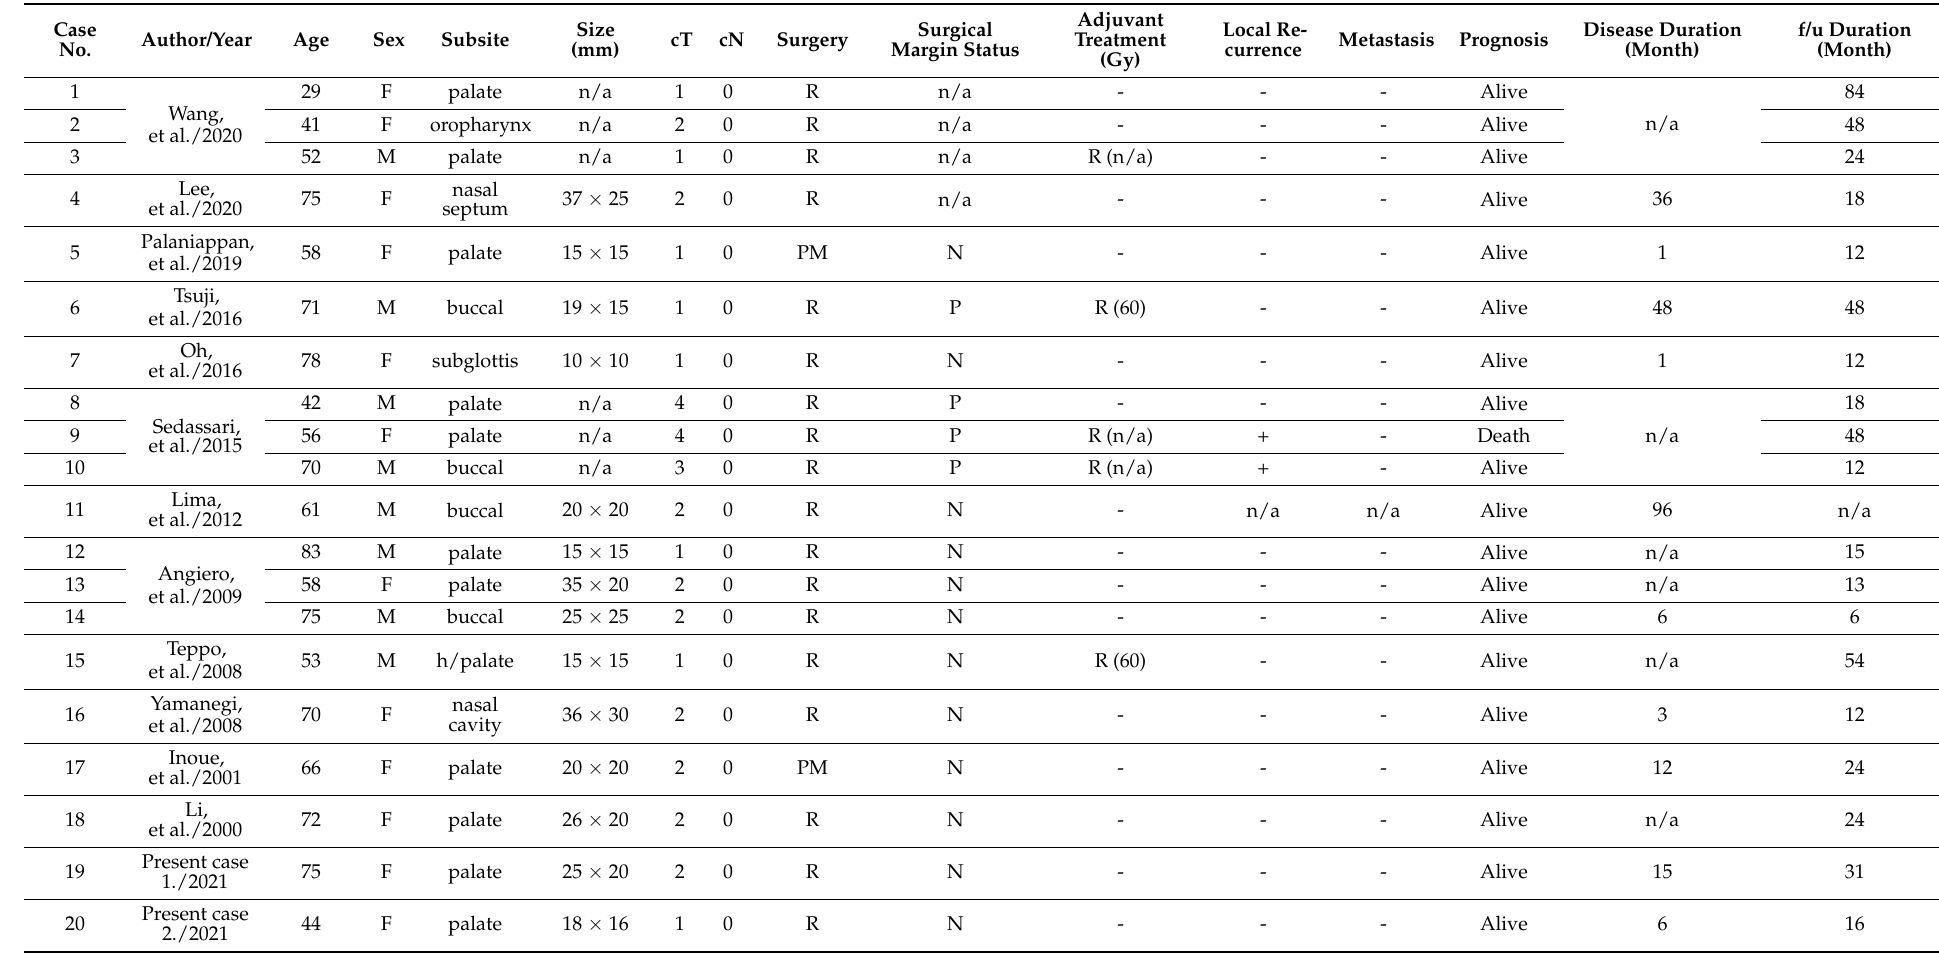
Table 1. Review of clinical characteristics of the cases with epithelial-myoepithelial carcinoma of the minor salivary